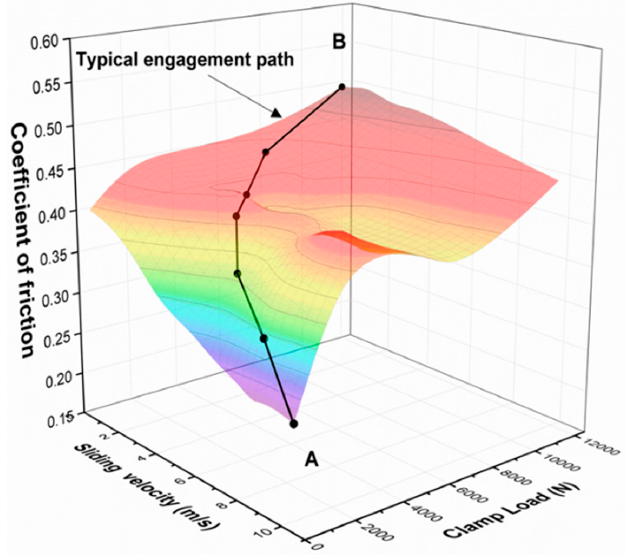
Figure 4. Characteristic 3D carpet plot of friction material with the typical engagement